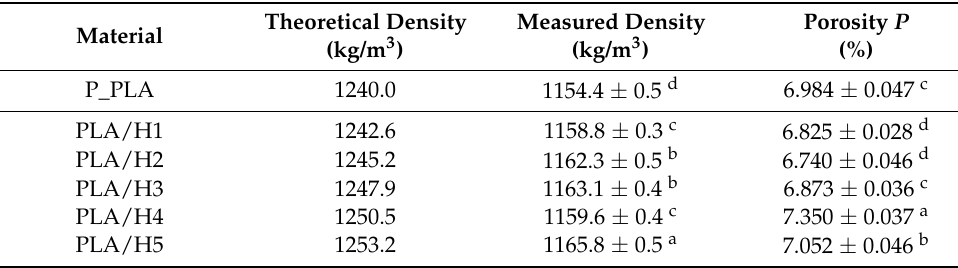
Table 2. Density and porosity values of the 3D printed materials. Material